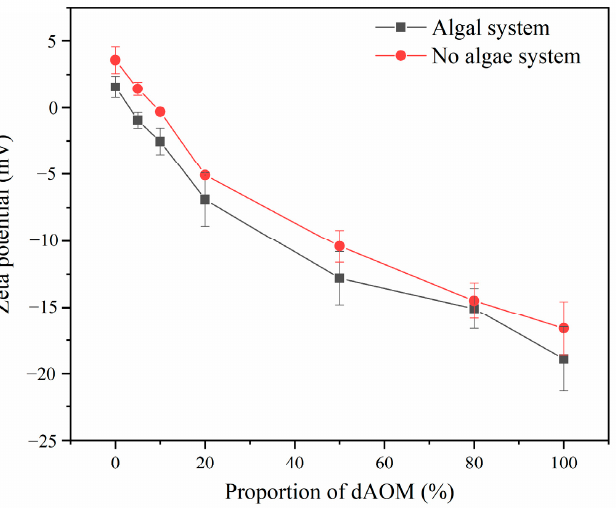
Figure 1. Zeta potential of MC in the algal and non-algal systems at different dAOM concentrations.